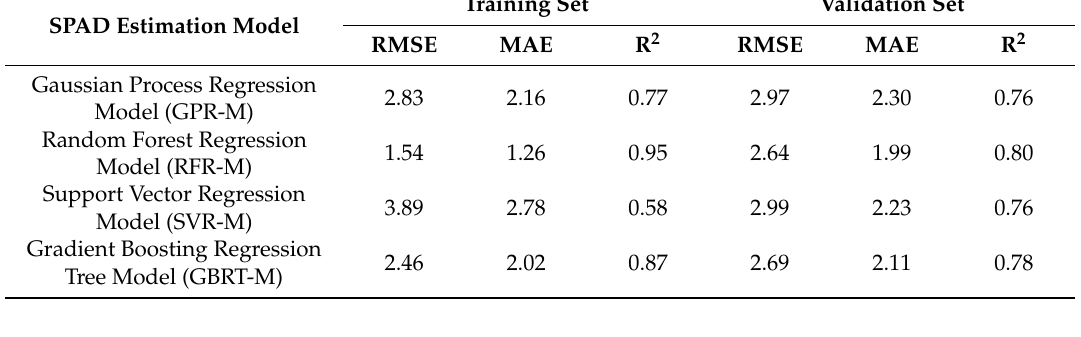
Table 3. Performance of the four machine learning models using the training set and validation set.